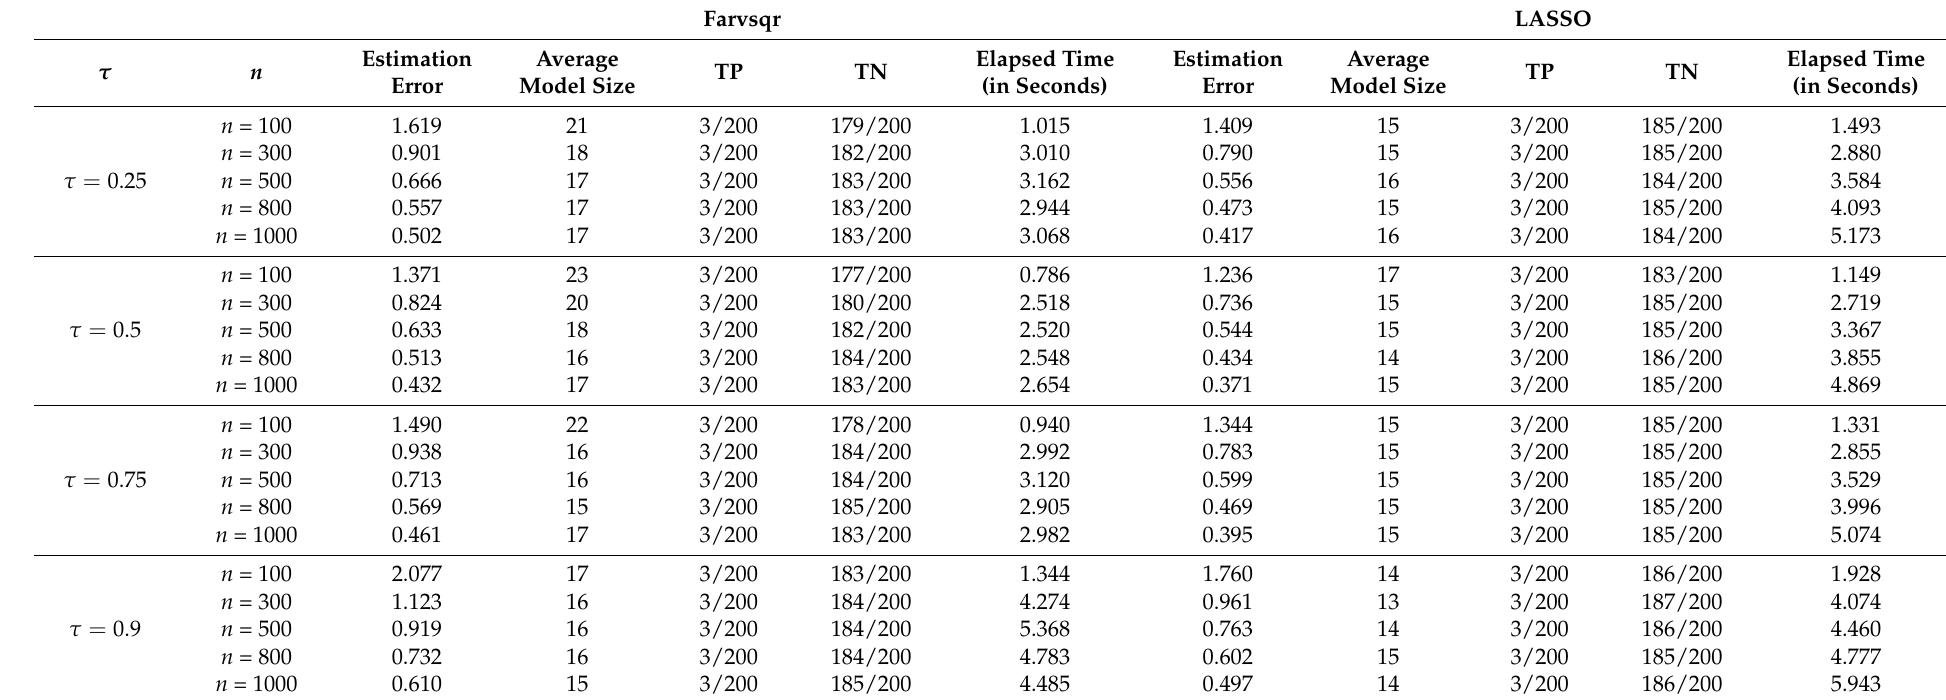
Table 9. The comparison for p = 200,0.1 ∗ N ( 0,1 ) + 0.9 ∗ N ( 0,9 ) with the equal correlated case. Farvsqr